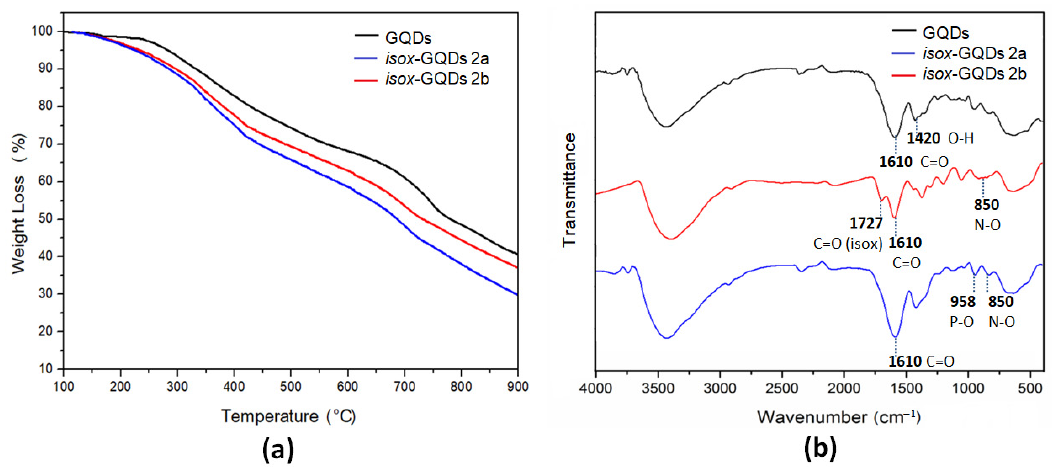
Figure 3. ( a ) TGA curves of GQDs, isox -GQDs 2a and isox -GQDs 2b , performed in Ar atmosphere; ( b ) FTIR spectra of GQDs, isox -GQDs 2a and isox -GQDs 2b .